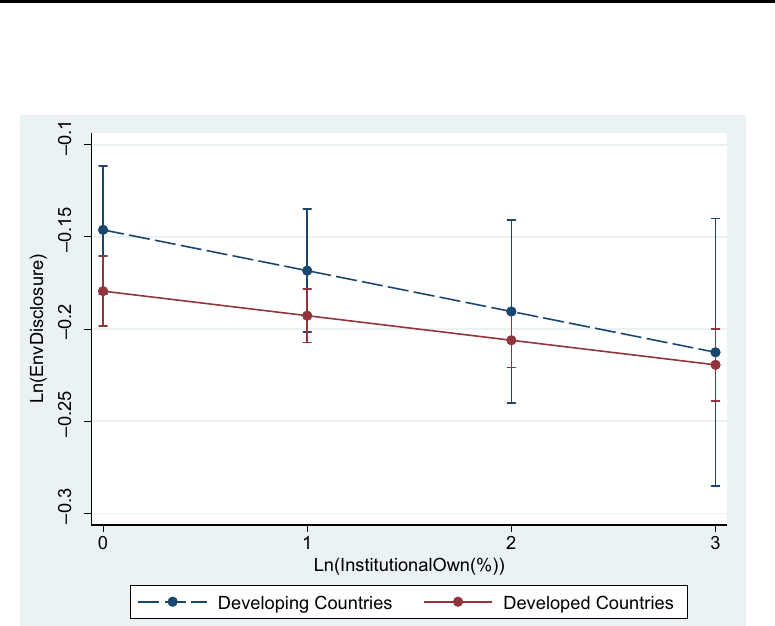
Table 6. Regressions results for H3 and H4